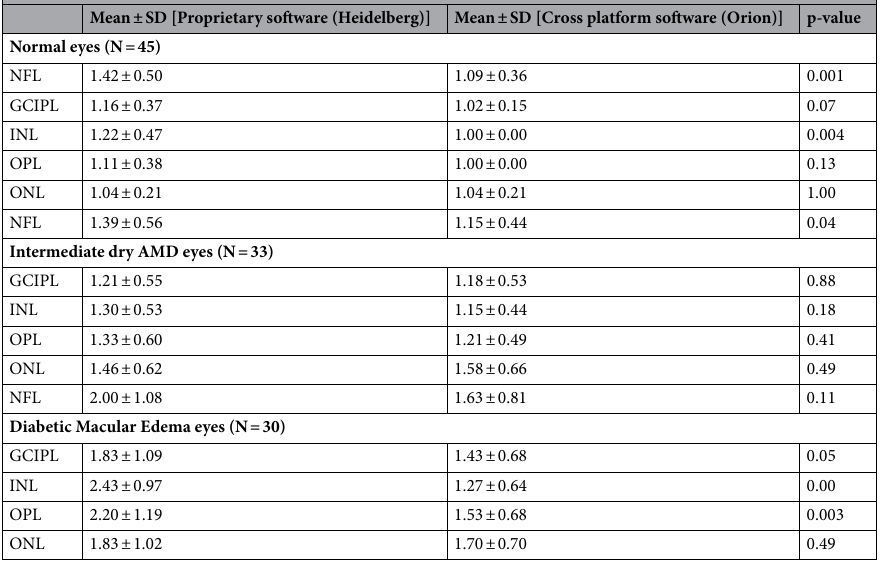
Table 2. Wilcoxon test comparing different layers in proprietary and cross-platform softwares. Segmentation quality grading scheme: 1 = Good, 2 = Mild, 3 = Moderate, 4 = Severe.